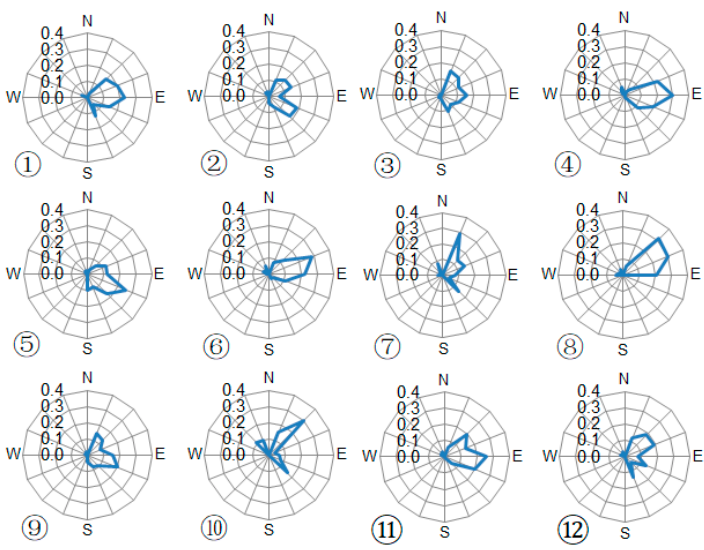
Figure 2. Wind roses for 12 AWSs (automatic weather stations) around Shanghai Metro Line 16 (Figure 1) during the typhoons that affected the city between 2005 and 2013 (Table 1). Observations were made with Vaisala WA 15 wind sensors at 10 m above ground level (agl), samples at 1 min.